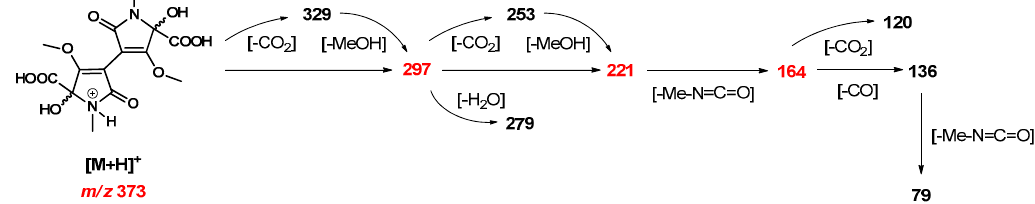
Figure 9. Proposed fragmentation of 14 upon CID (according to Figure 8C). Red numbers indicate the most intense fragments.